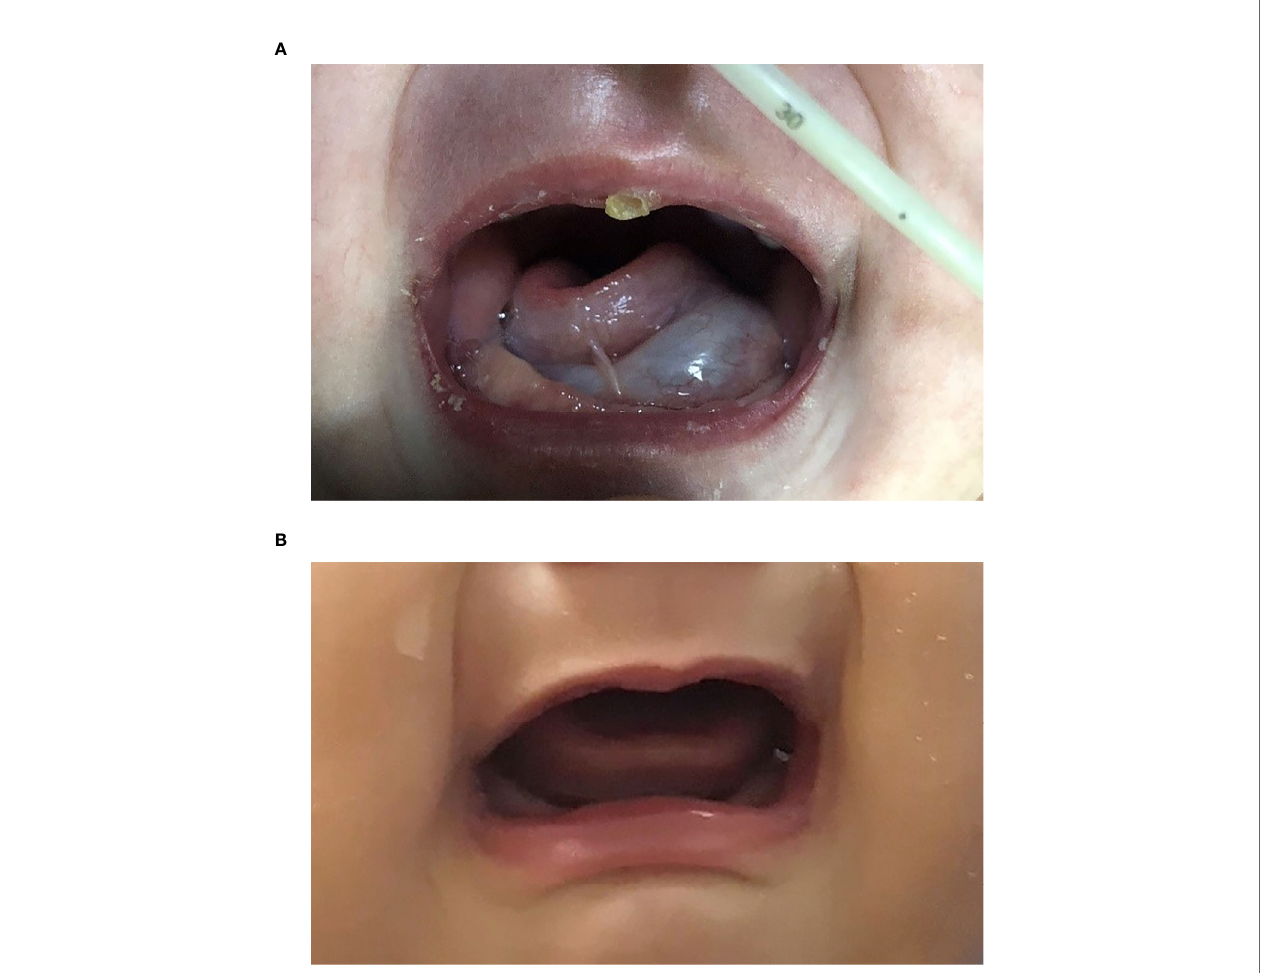
FIGURE 2 | Two-month-old female (patient 4 in Table 1 ) with extensive bilateral microcystic cervicofacial lymphatic malformations with tongue and fl oor of mouth involvement at (A) start of therapy, and (B) at 6 months. This patient also has extensive bilateral submandibular and facial involvement, which also signi fi cant regression during sirolimus therapy (not